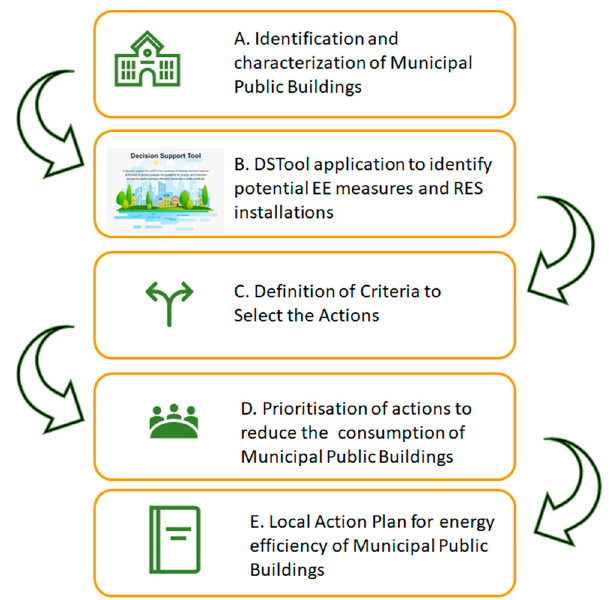
Figure 2. Step-by-step procedure to implement a Local Action Plan using the PrioritEE DSTool.